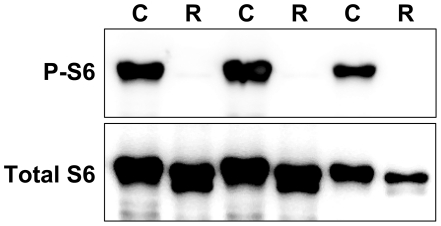
Demonstration of rapamycin in vivo effect.Extracts were prepared using liver samples from three control (C) and three rapamycin-treated (R) rats. The extracts (80 µg protein per lane) were analyzed by direct immunoblotting for phosphorylated ribosomal protein S6 (P-S6) and total S6.